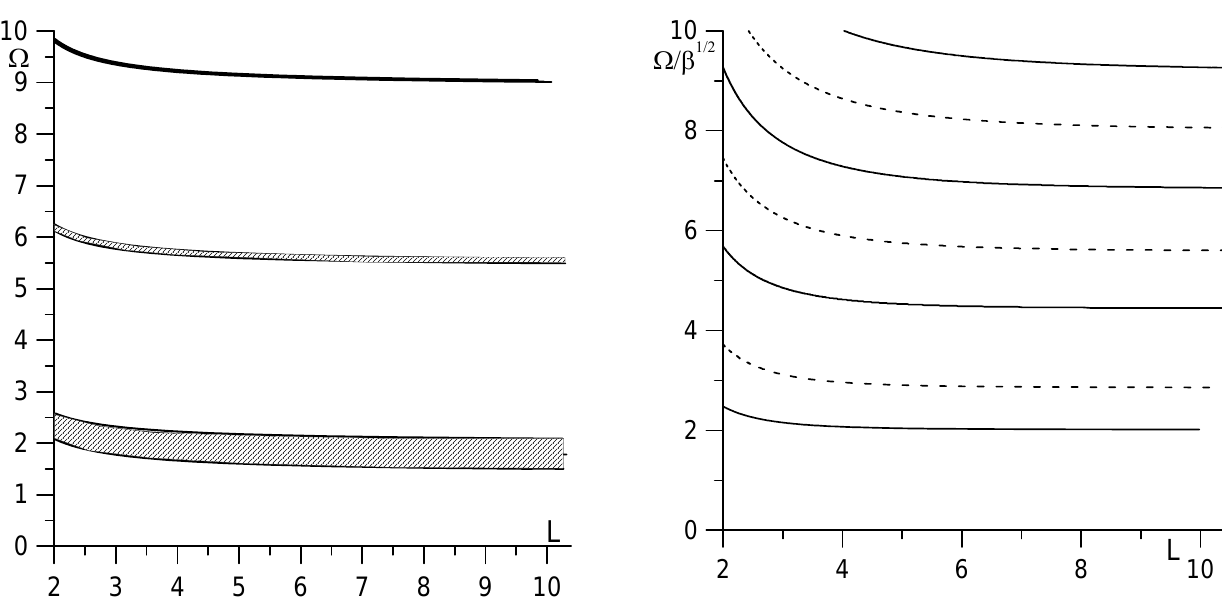
Fig. 1b. The spectrum of slow magnetosonic modes (solids – even, Fig. 1a. Dependence of Alfv´en spectrum on McIlwain number in dashes – the cold plasma case with ideal conductive ionospheres. The finite width of the spectral lines is due to different eigenmode polariza- tions (upper limit – toroidal, lower – poloidal). Figure 1b. The spectrum of slow magnetosonic modes (solids — even, dashes — odd). Figure 1a. Dependence of Alfvén spectrum on McIlwain number in cold plasma case with ideally conductive ionospheres. The finite width of spectral lines is due to different eigenmode polarizations (upper limit — toroidal, lower — poloidal).